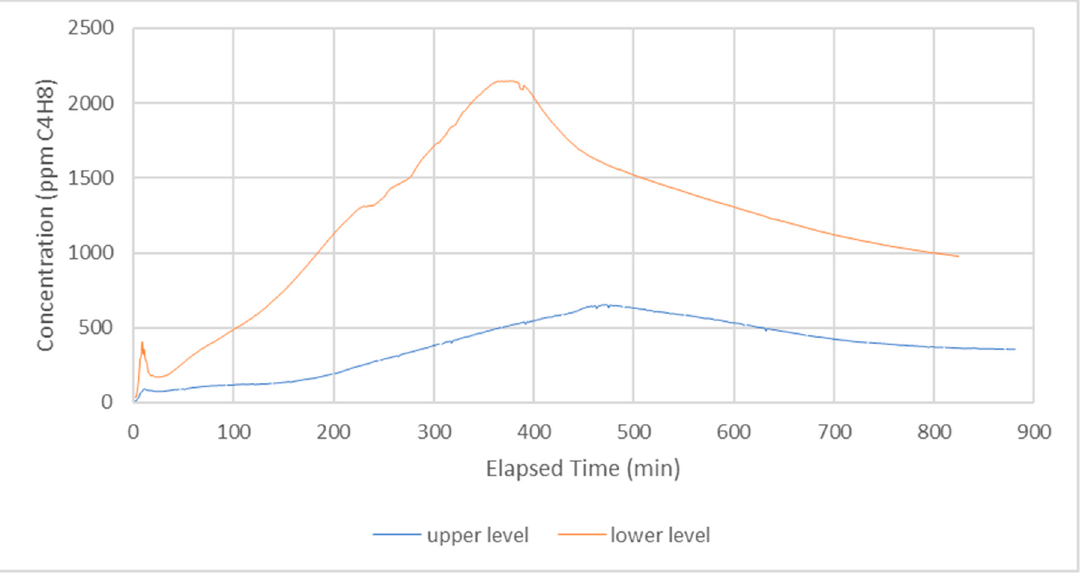
Figure 2. Data plots for 27 June 2016.